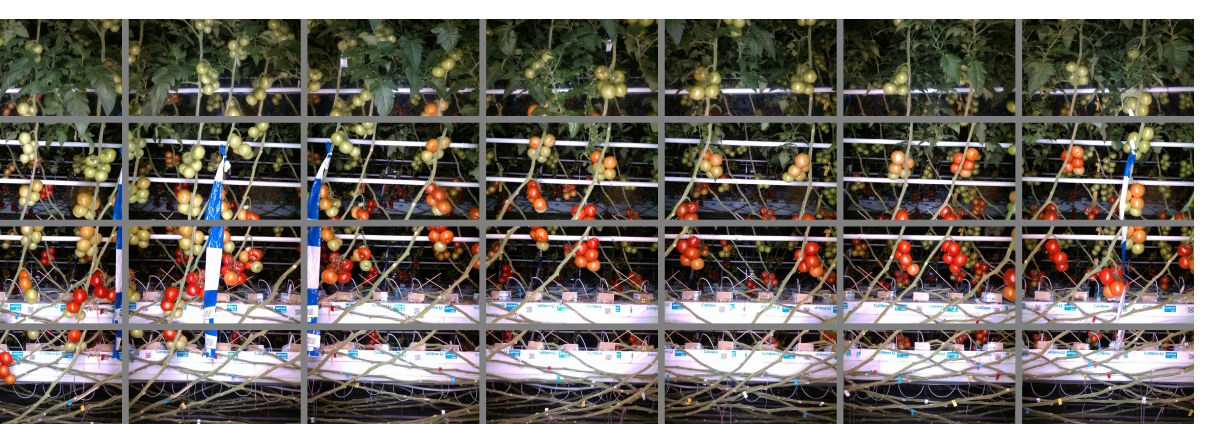
Figure 2. An example of a sequence of images over one plot. The images taken by the four cameras are stacked vertically according to camera position. Each plot consists of four plants of the same variety, delimited by the blue and white